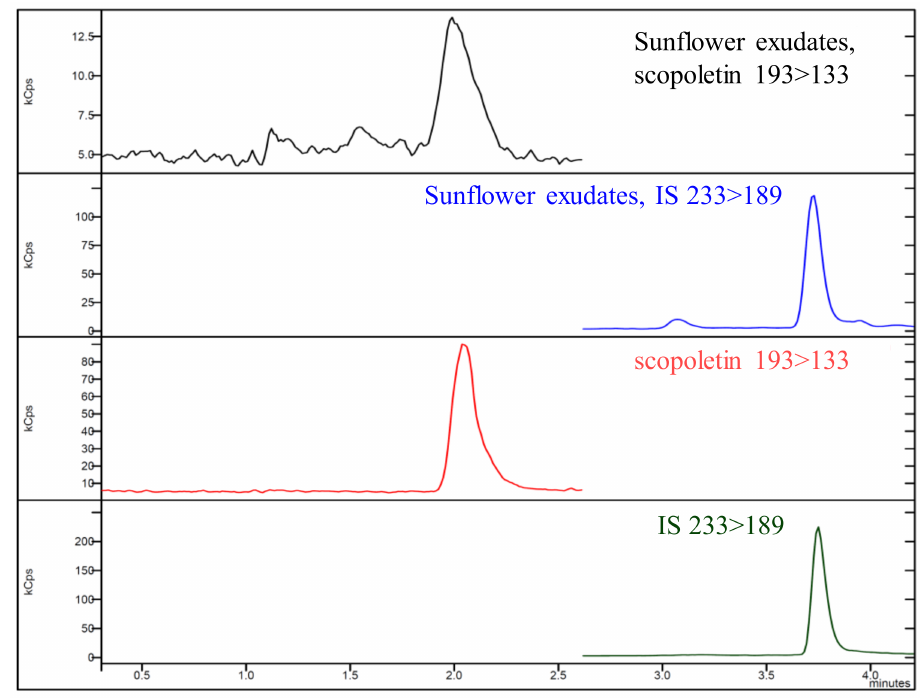
Figure 3. Chromatogram of sunflower exudate, scopoletin, and the